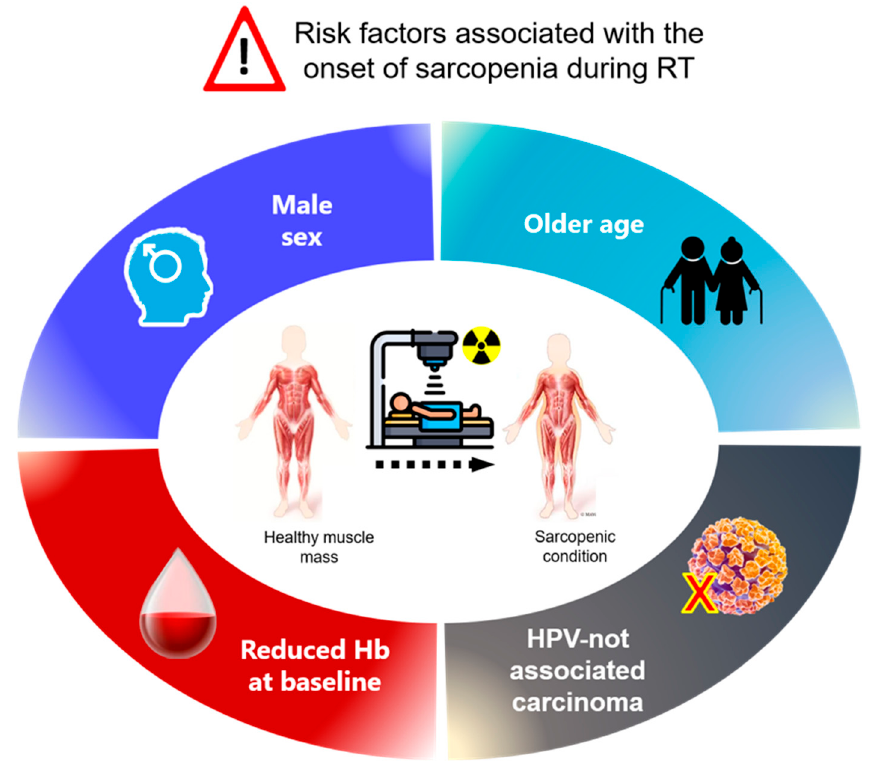
Figure 4. Profile of the patient most at risk for the onset of sarcopenia during radiotherapy.